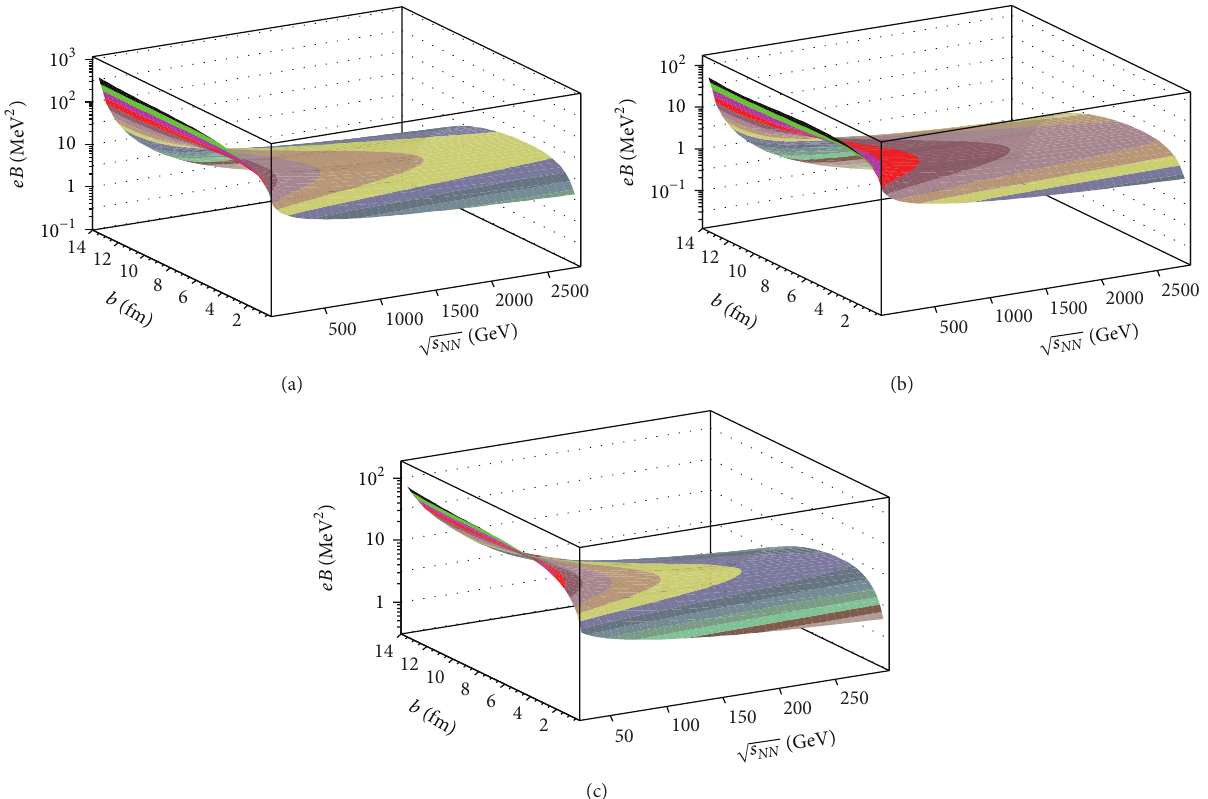
Figure 7: The dependencies of the magnetic field on collision energies of central mass system and impact parameters at different proper times for 𝜏 = 1.0 fm (a), 𝜏 = 2.0 fm (b), and 𝜏 = 3.0 fm (c),